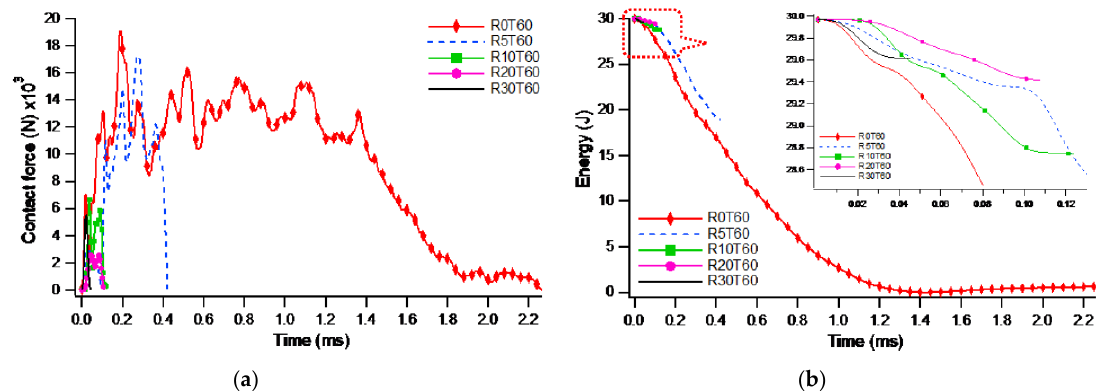
Figure 15. Comparison of 30 min sintered test specimens for: ( a ) contact force−time (F−t); ( b ) energy-time (E−t) curves of impactor; the inset is a magnification of the region indicated by the red dashed line.